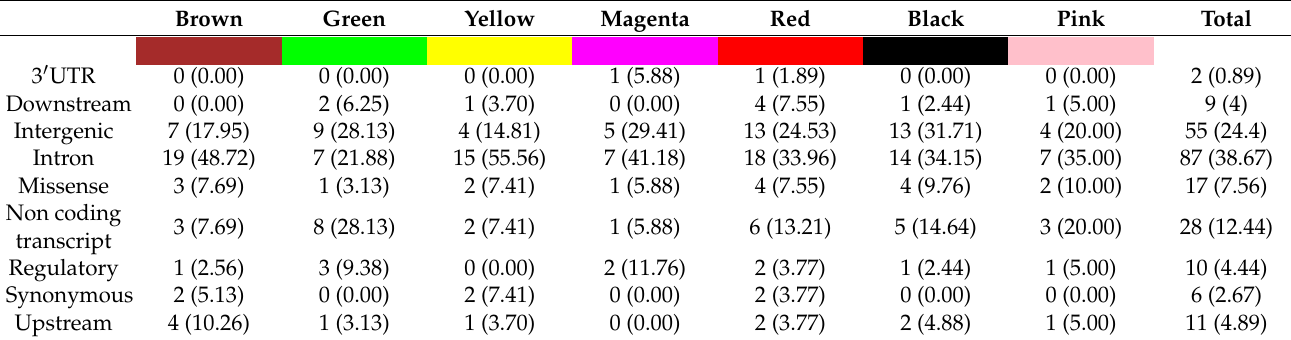
Table 4. Annotations of SNPs correlated with